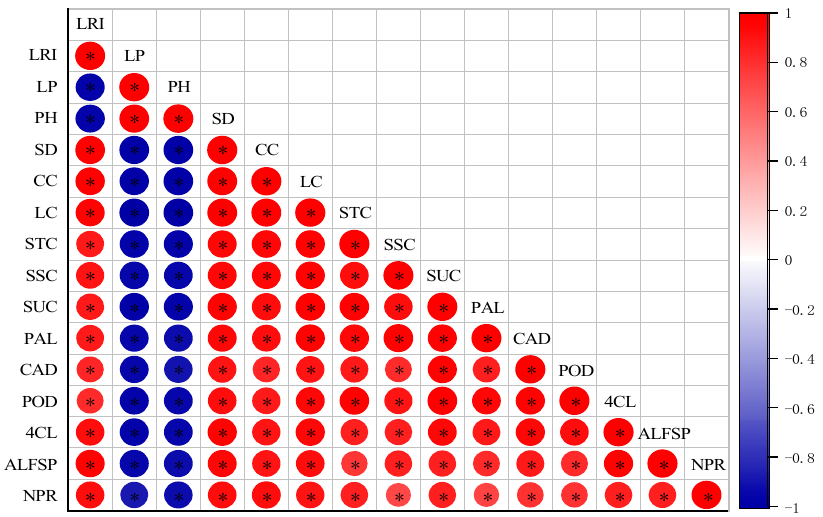
Figure 9. Contribution rate of lignin content (LC), soluble sugar content (SSC), and phenylalanine ammonia-lyase enzyme activity (PAL) ( a ); cellulose content (CC), starch content (STC), and peroxidase (POD) content ( b ); and sucrose content (SUC), 4-coumaric acid: CoA-ligase enzyme activity (4CL), and Cinnamyl alcohol dehydrogenase enzyme activity(CAD) ( c ) to stem strength (SS) under three different density treatments (PD1 = 17, PD2 = 20, and PD3 = 25 plants m − 2 ), respectively. All the values are means (±SE) standard error of three replications.